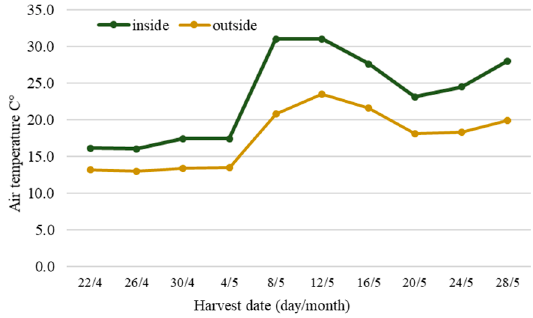
Figure 4. Air temperature outside and inside the greenhouse. The total and cumulative concentrations of anthocyanin were evaluated. The cumu- lative amount is the amount of anthocyanins in a particular harvest plus the amount in previous harvests. Anthocyanins were extracted from frozen berries using 90% aqueous methanol, with 0.02% HCl at a 1:20 g:mL ratio [42], and concentrated in rotary evaporator at 37 ◦ C. Residues were dissolved in acidified water (pH 2.4). The anthocyanin composition was analyzed using an Agilent 1200 HPLC system with a DAD detector (Agilent, Germany); ticle size 3.5 µ m) was used for separation. The mobile phase consisted of 10% acetic acid